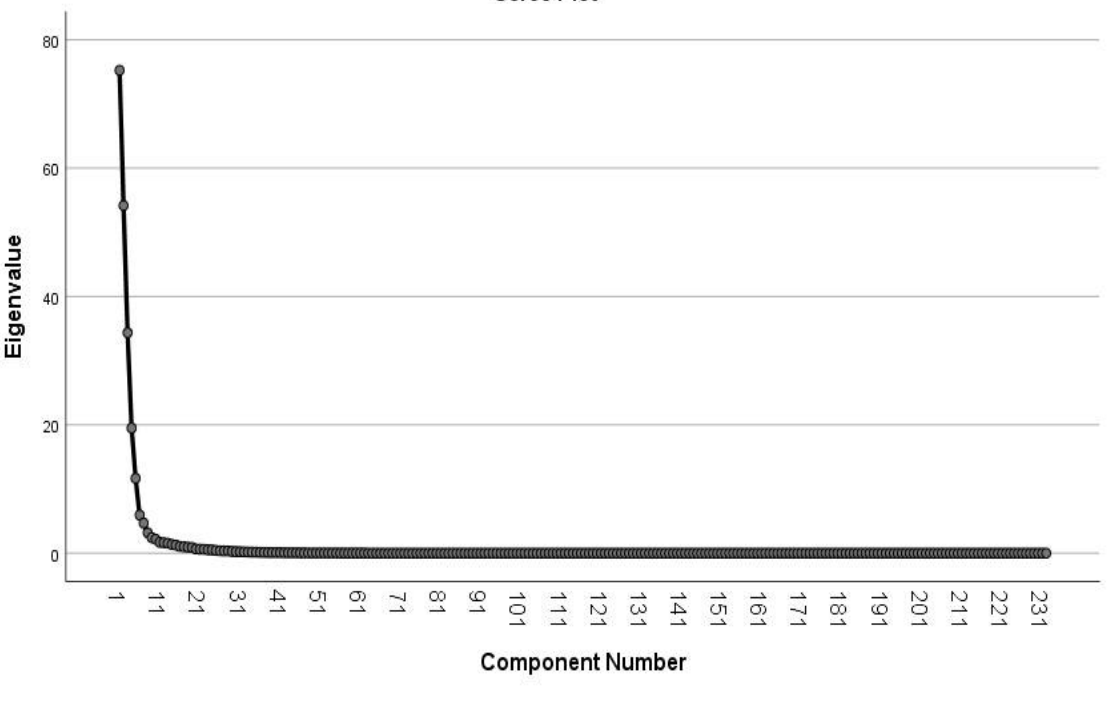
Figure 4. Scree plot explaining the spread of principal components.